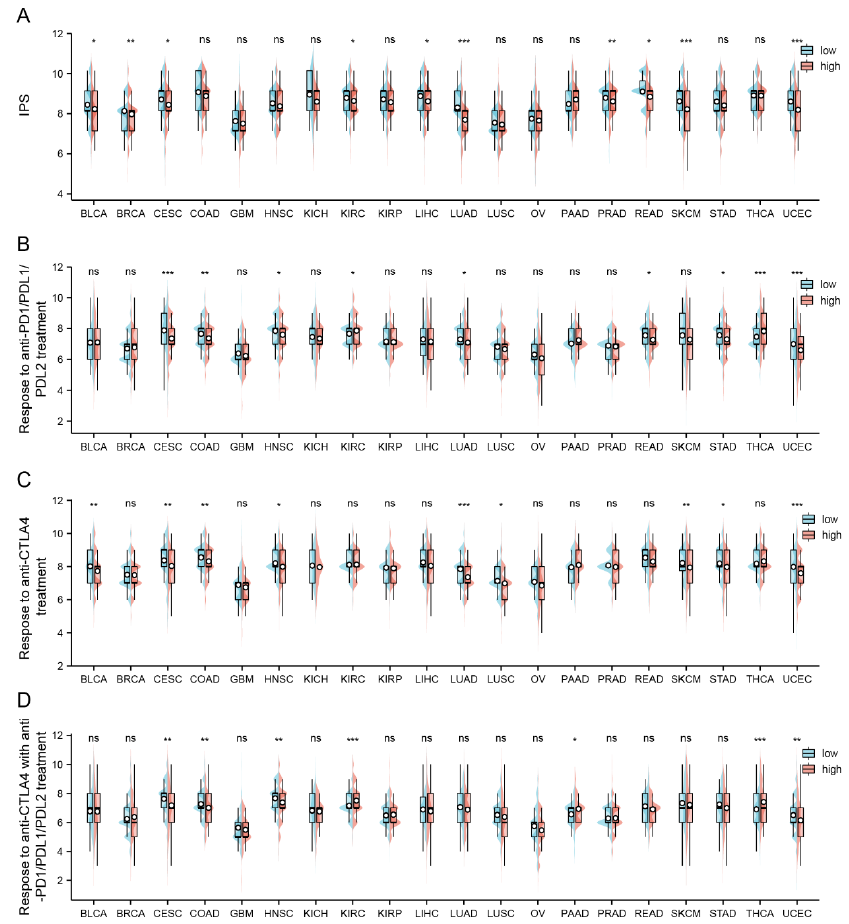
Figure 6. Assessment of immunotherapy response between FAM72A high and FAM72A low groups in pan-cancer. ( A ). Evaluation of immunophenoscore (IPS) for FAM72A high and FAM72A low groups, reflecting tumor immunogenicity. ( B – D ). the possibility of responding to anti-PD1/PDL1/PDL2 ( B ), anti-CTLA4 ( C ), and the combination ( D ) for the two groups across different cancers. ns, not significant, * p < 0.05, ** p < 0.01, and *** p <